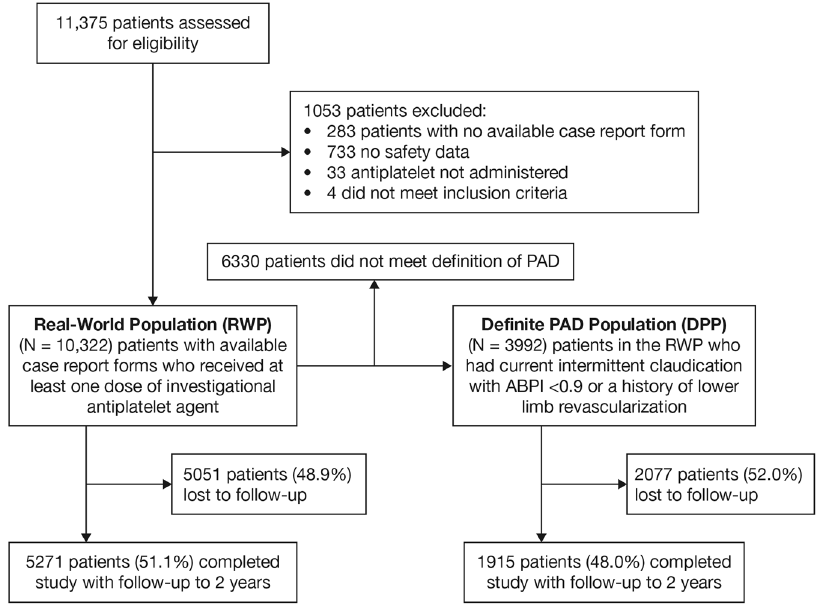
Figure 1. Patient Disposition. ABPI indicates ankle-brachial pressure index; PAD, peripheral arterial